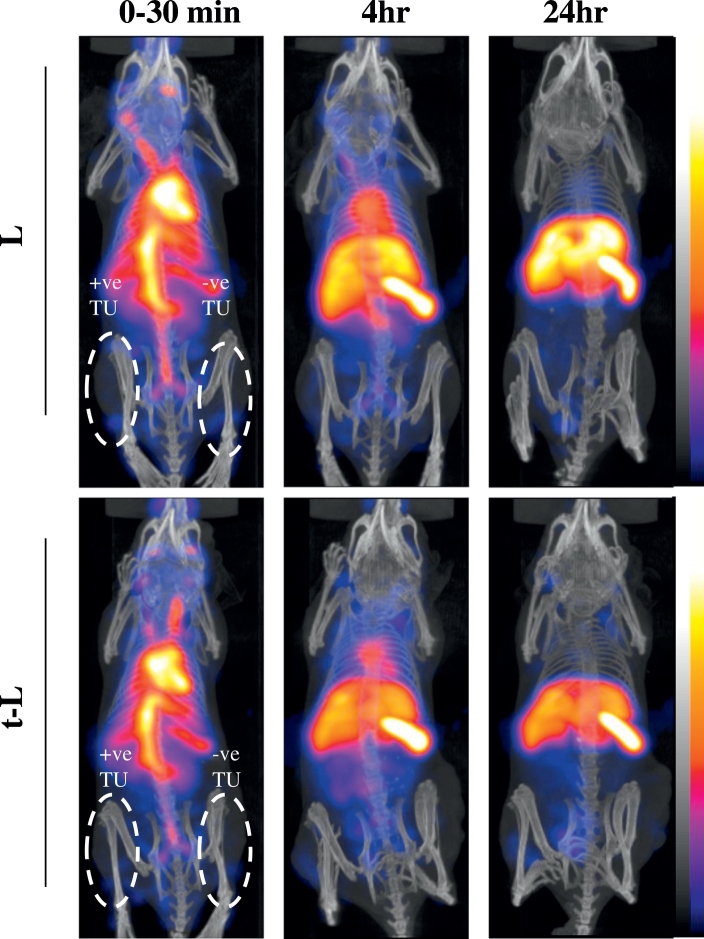
In vivo whole body 3D SPECT/CT imaging of 11In labelled liposomes in tumour-bearing immunocompromised mice. Mice were i.v. injected with 111In labelled liposomes at a dose of 2 μmol lipid/mouse. Mice were inoculated bi-focally with the αvβ6 positive tumour on the left of the image (A375Pβ6) (right flank) and the negative tumour (A375Ppuro) on the right of the image (left flank). Whole body 3D SPECT/CT imaging were performed at 0–30 min, 4 and 24 h post-injection with scanning time of 40–60 min each. SPECT data is displayed in colour scale and CT data is in grey scale, respectively (high to low signals: top to bottom).